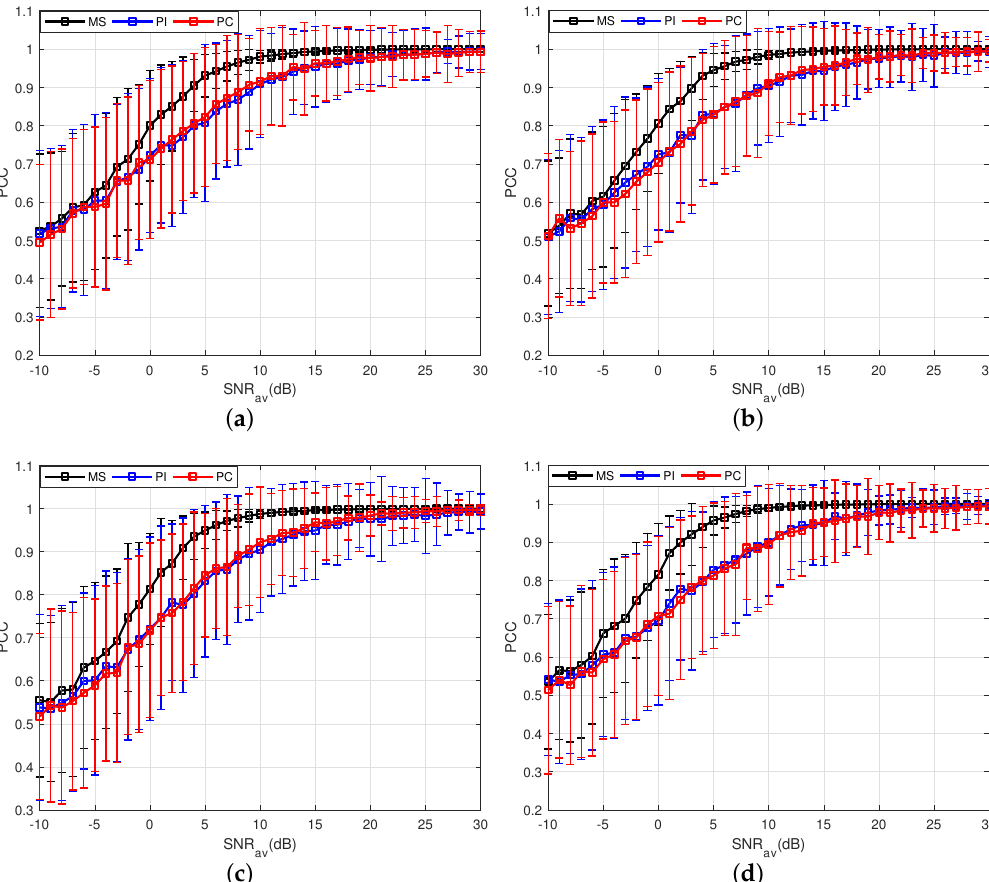
Figure 4. Results of three PSM estimation methods for different integrated pulses. ( a ) Results of three PSM estimation methods where N = 4; ( b ) Results of three PSM estimation methods where N = 6; ( c ) Results of three PSM estimation methods where N = 8; ( d ) Results of three PSM estimation methods where N =